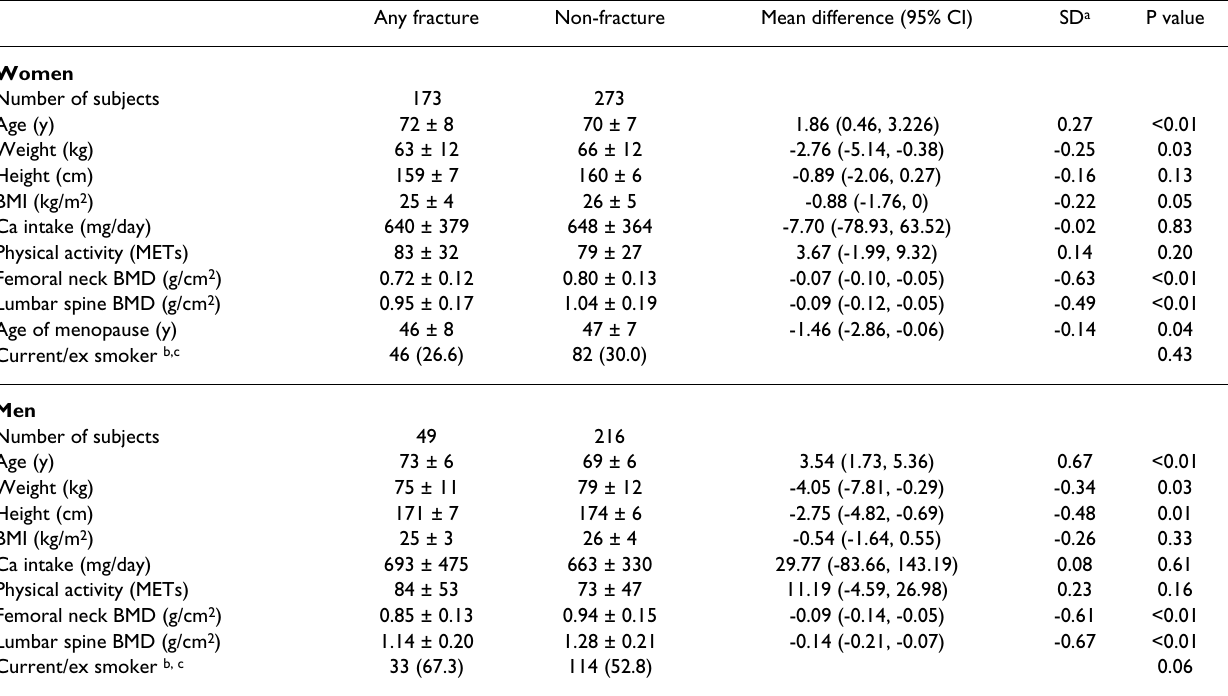
Table 3: Baseline characteristics of subjects with and without fracture Any fracture Non-fracture Mean difference (95% CI) SD a P